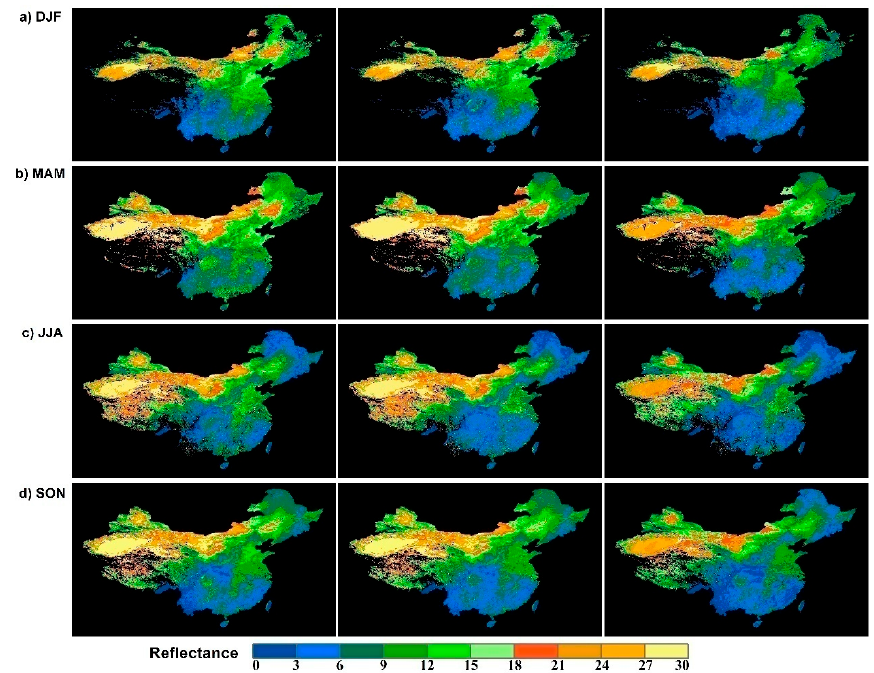
Figure 6. Comparisons of three seasonal maps of surface reflectance at 0.67 µm obtained from the Simplified AtmospHeric correction AlgoRithm for gAofen data (SAHARA) coefficients ( left ), MOD09 ( middle ), DB coefficients ( right ) respectively. ( a – d ) are the comparison of DJF, MAM, JJA, and SON respectively.